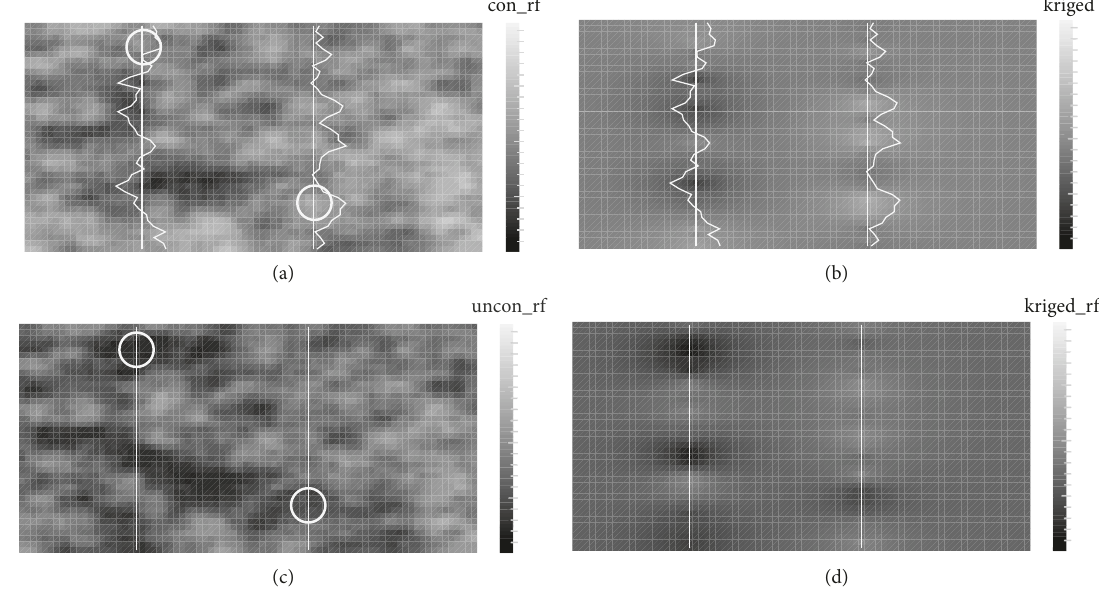
Figure 4: The four fields for realisation i . (a) Conditional random field i . (b) Kriged field based on measurements. (c) Unconditional random field i . (d) Kriged field i based on random values at measurement